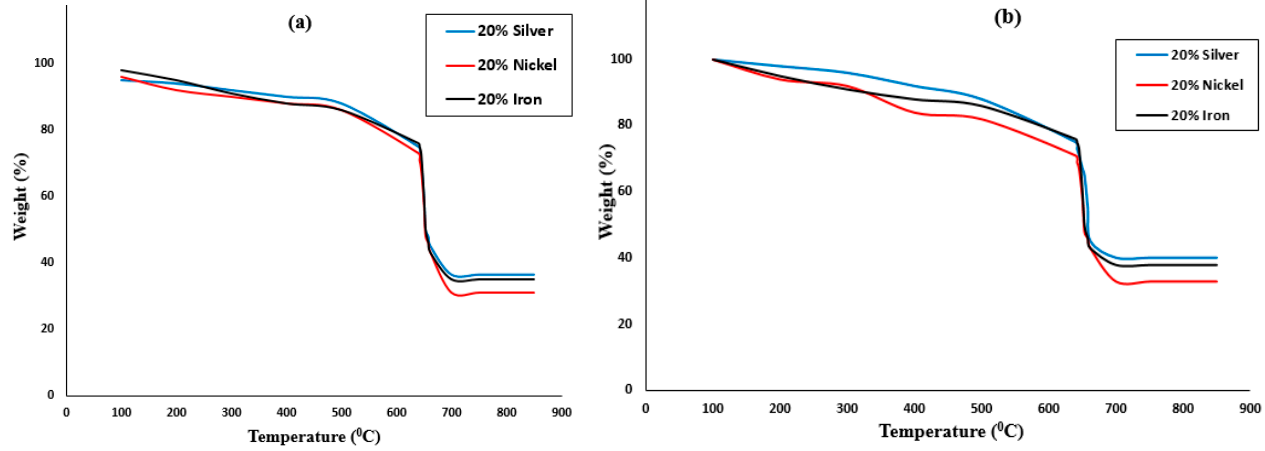
Figure 8. The TGA profile of ( a ) synthesized SWCNTs with different catalysts, and ( b ) h -BN-SWCNT composites under the same catalytic conditions.